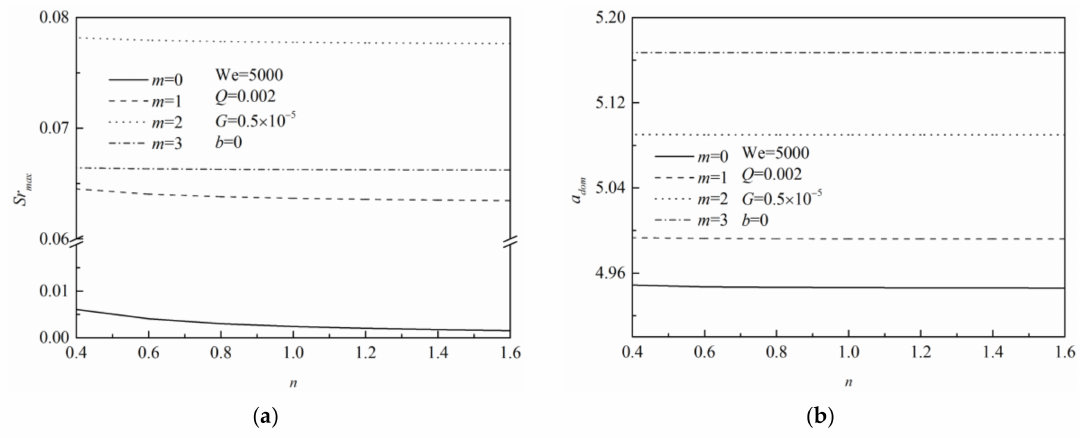
Figure 8. E ff ect of the power-law exponent on the maximum growth rate ( a ) and the dominant wavenumber ( b